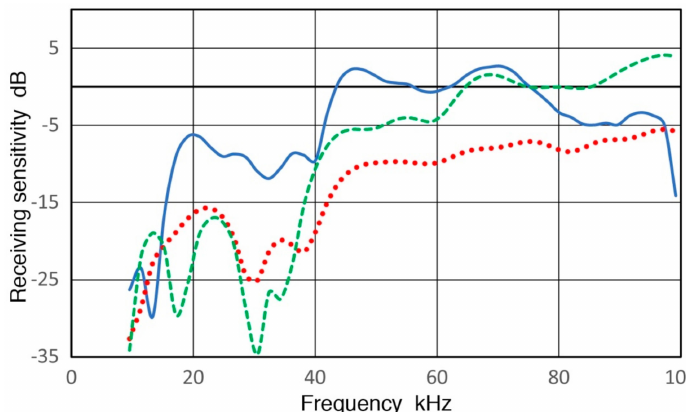
Figure 1. Receiving displacement sensitivities of three low frequency AE sensors. Blue curve: PAC R.45, Red dot: PAC R3a, Green dash: PAC R6a. Sensitivity in dB in reference to 1 V/nm. Input impedance = 10 k Ω